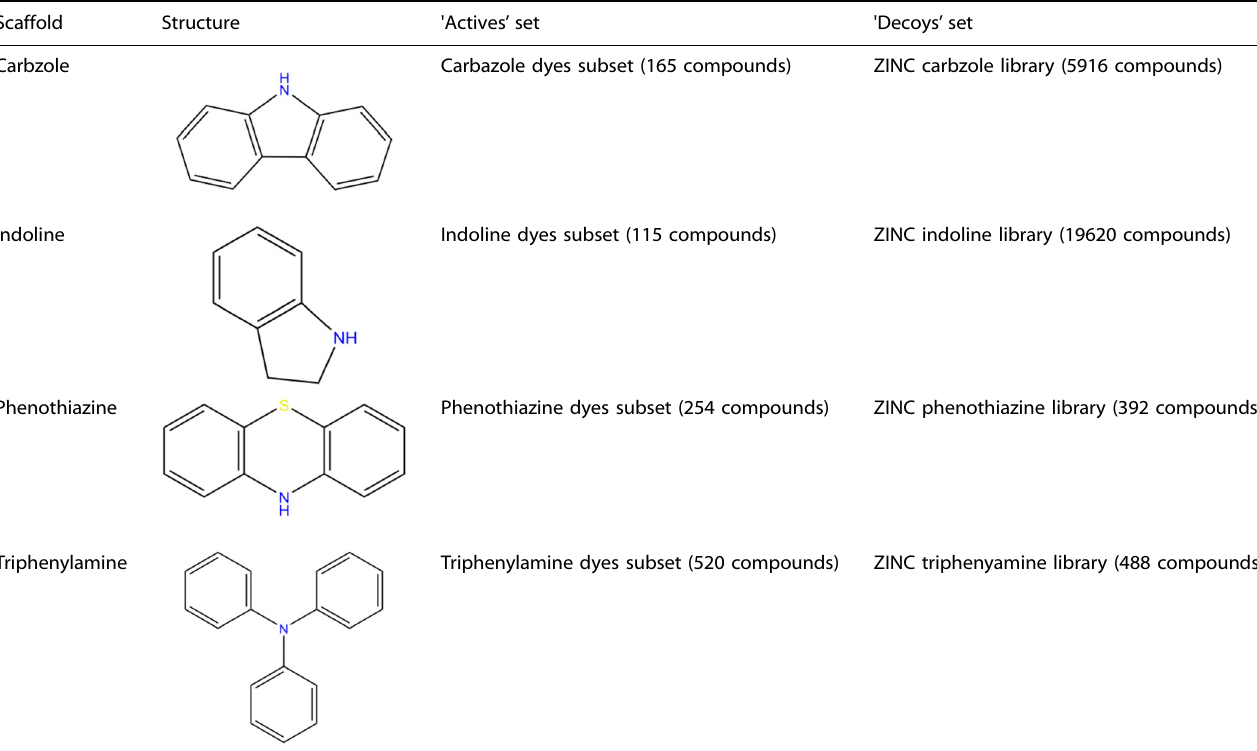
Table 2. Scaffolds used for pharmacophore generation, with their matching validation sets.